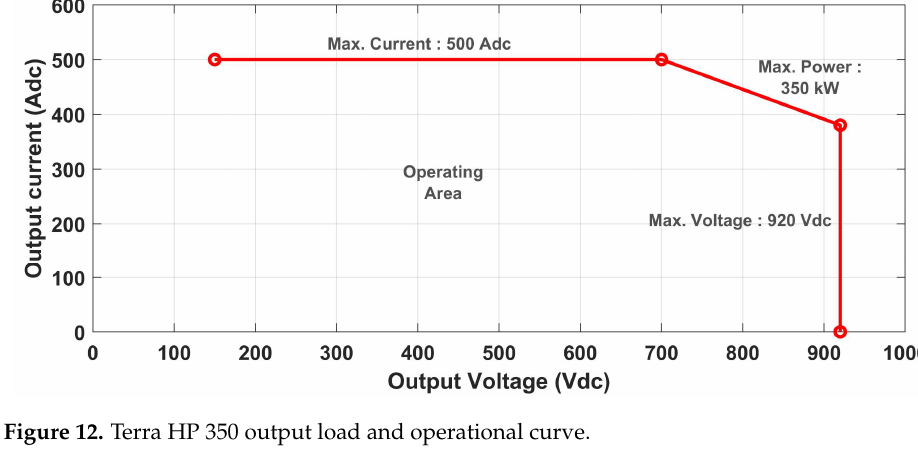
Figure 12. Terra HP 350 output load and operational curve.